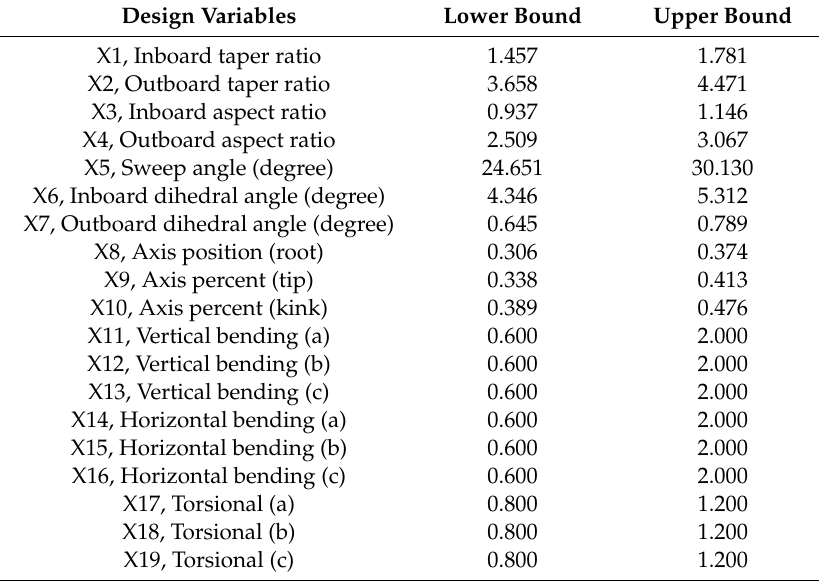
Figure 1. Genetic algorithm flowchart. Table 1. Bounds of 19 design